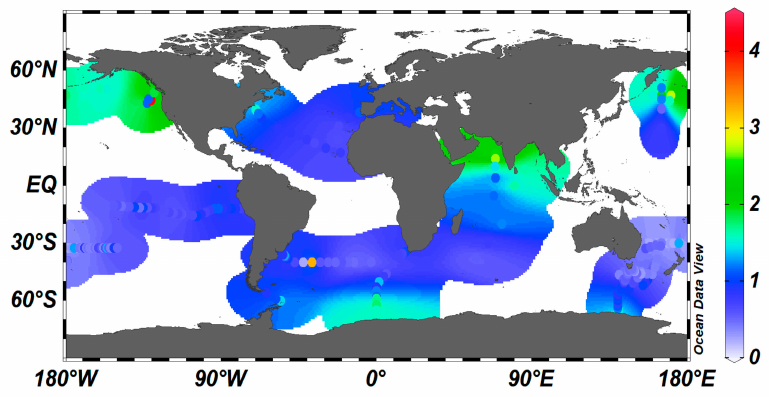
Figure 4. Dissolved Cu in surface seawater. The color bar refers to the concentration of dissolved Cu in the unit of nmol kg − 1 . Data source: Schlitzer et al. [100]. Map was produced using Ocean Data